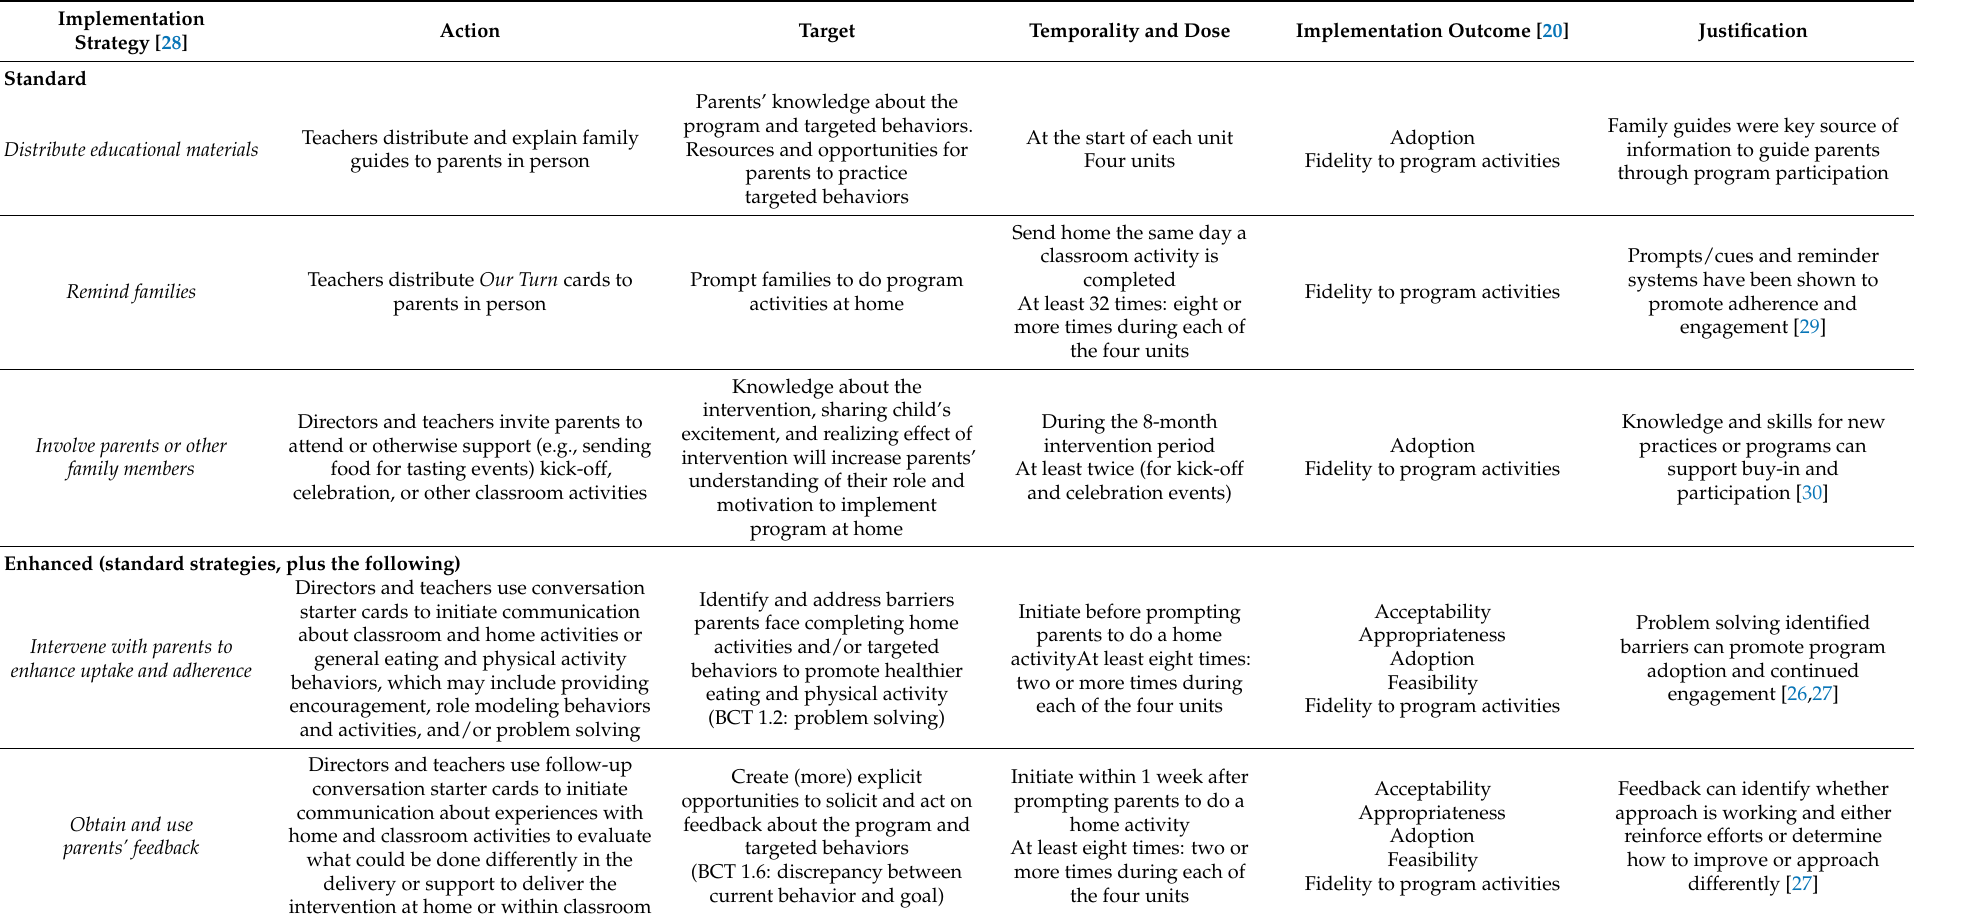
Table 1. Discrete implementation strategies [28] selected for early care and education providers (actors) to use with parents of 3–4-year-old children (target) to support adoption and implementation of the Healthy Me , Healthy We